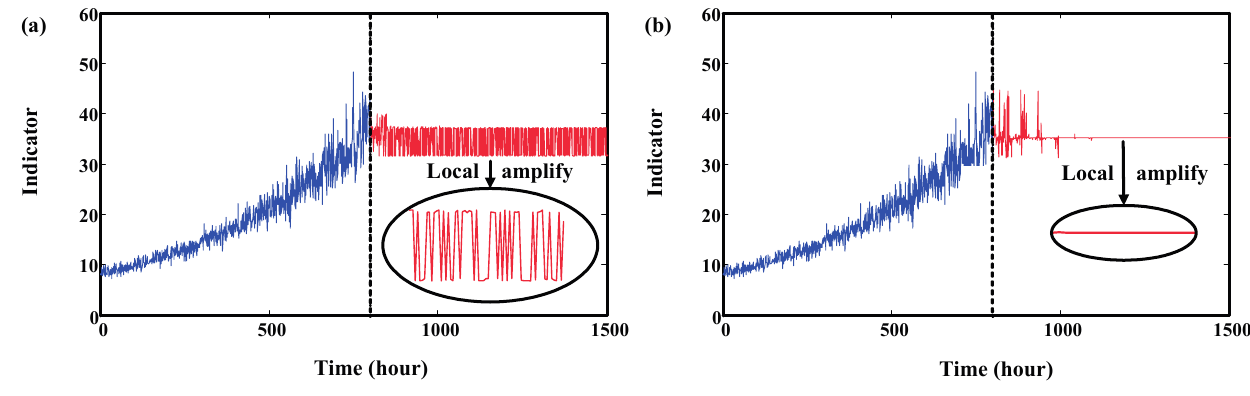
Figure 4. Results of rolling prediction. ( a ) Results fluctuate in a range; ( b ) Results keep the same